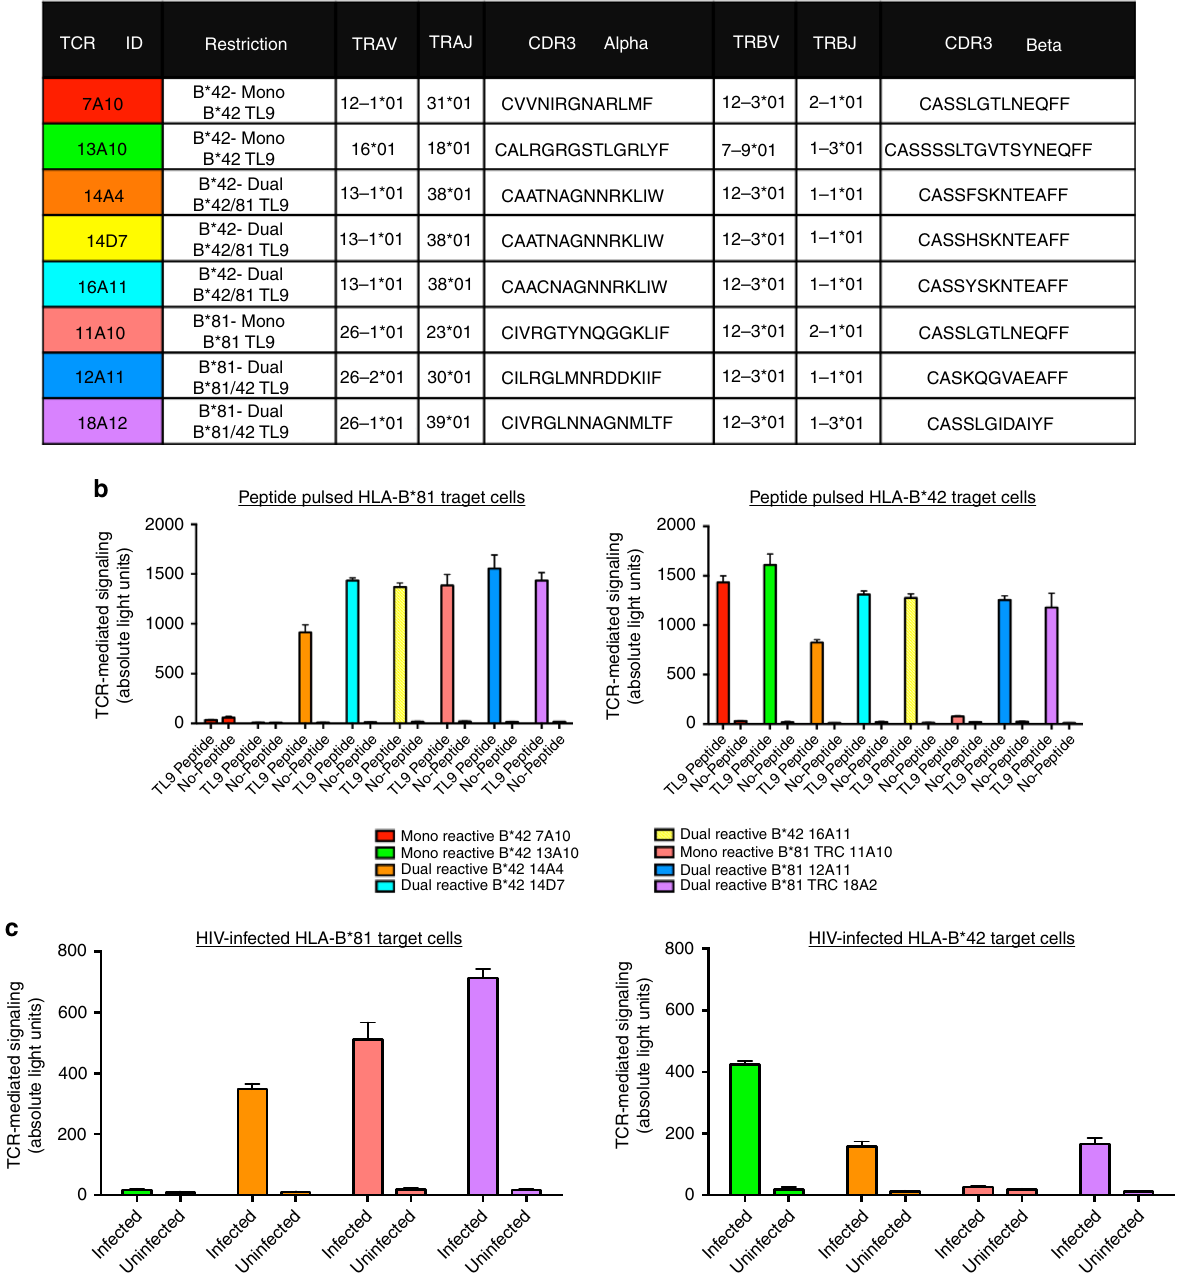
Fig. 4 In vitro validation of TCR speci fi city and dual-reactivity. Details for the eight TL9-speci fi c TCR clones investigated in this study are shown, including donor HLA, mono- or dual-reactivity phenotype, paired TCR α / β V gene usage and CDR3 sequences ( a ). Jurkat T cells were co-transfected with TCR α / β , CD8 α and an NFAT-driven luciferase reporter vector, and then co-cultured with TL9 peptide-pulsed ( b ) or HIV-infected ( c ) target cells stably expressing B*81:01 or B*42:01. TCR-dependent NFAT signaling was quanti fi ed by luminescence. The expected mono- or dual-reactive phenotype was observed for all reconstructed TCR clones, as indicated by greater luminescence (absolute light units, y -axis) in the presence of TL9-pulsed or virus-infected target cells compared to no-peptide or uninfected controls. Assays were conducted at least three times. Results from a representative experiment are shown as the mean of three co-culture reactions, plus standard